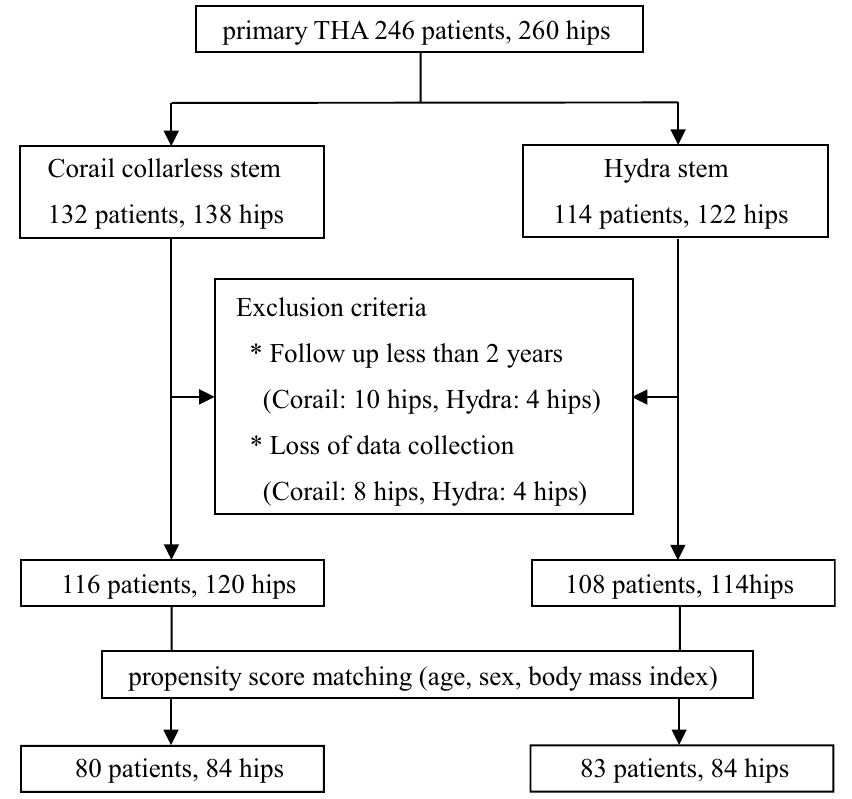
Figure 4. Flowchart showing the inclusion and exclusion of patients with follow